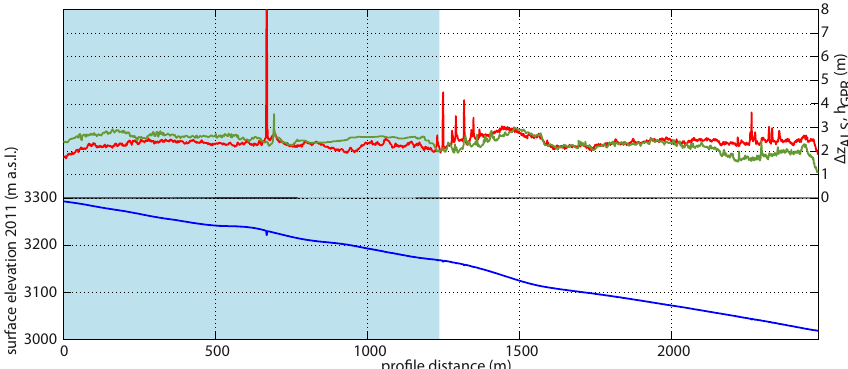
Fig. 12. Elevation of the surface in fall 2011 (blue curve), ALS surface elevation change 1z ALS (red curve) and GPR snow depth h GPR (green curve) along the longitudinal profile K4 at Kesselwandferner. Snow covered areas derived from Landsat image of 31 August 2009 (LSC) are shaded in